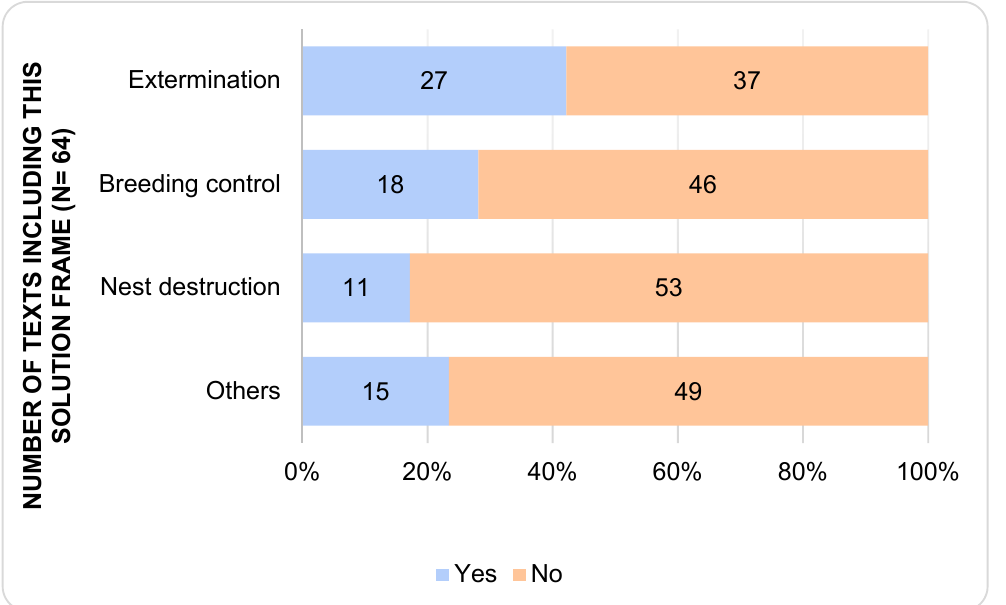
Figure 3. Proportion of each frame within the analyzed texts. Source: Own elaboration from texts from El País , El Mundo , ABC , elDiario.es , Público , and El Español .